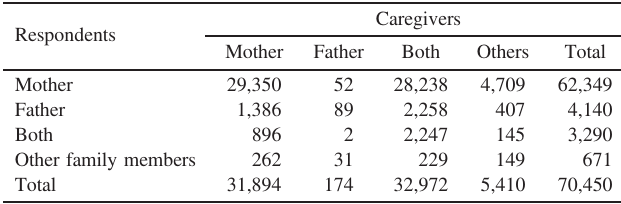
Table 1. Distribution of respondents of the survey and caregivers